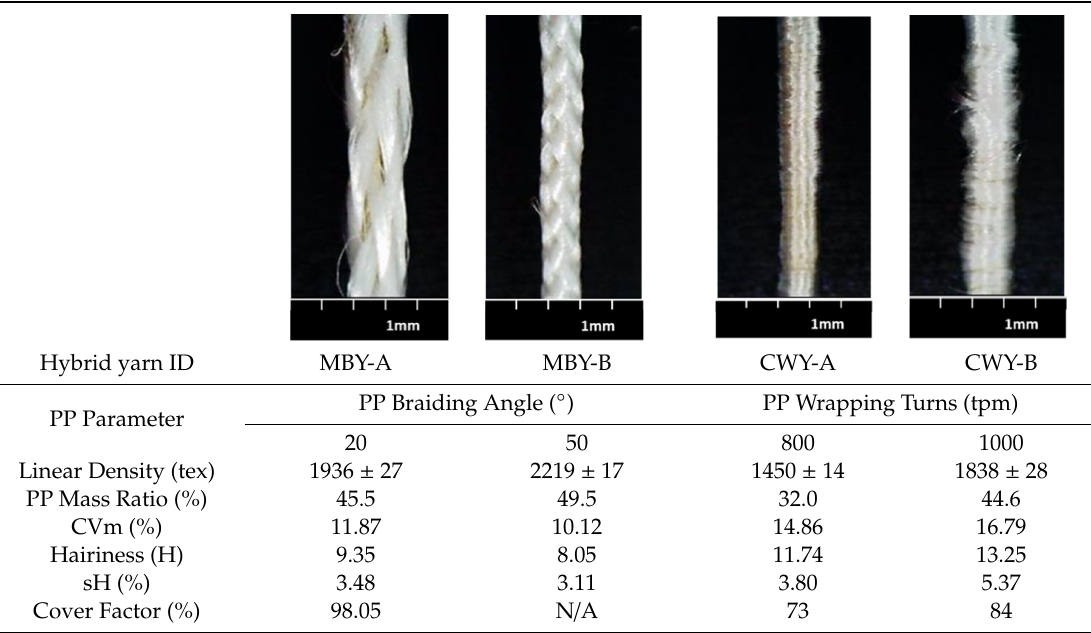
Table 2. Morphologies and textile properties of MBYs and CWYs.